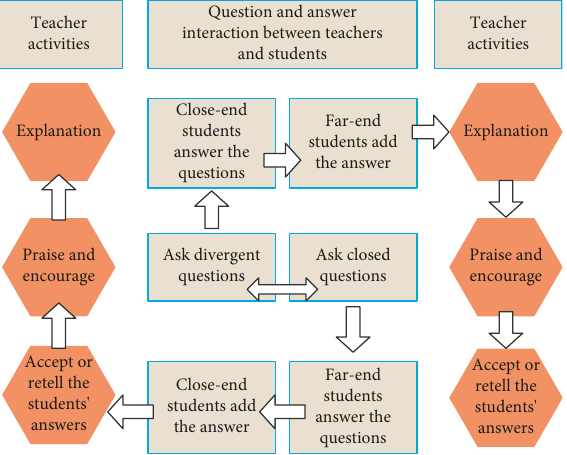
Figure 8: Synchronous classroom interaction